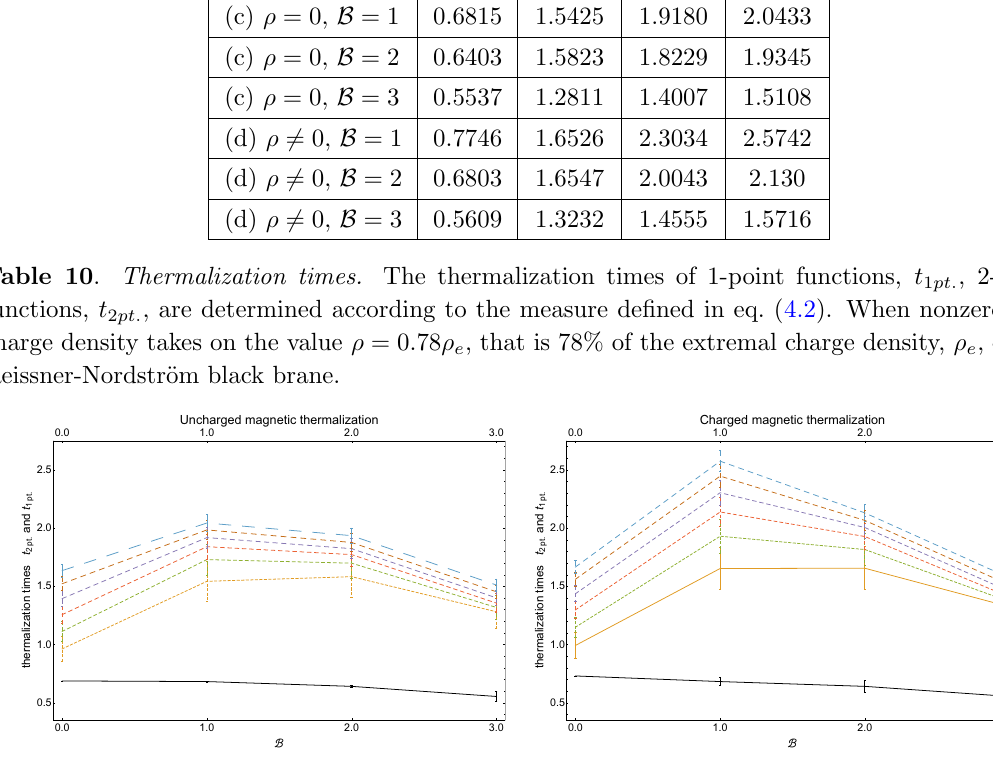
Figure 19 . Thermalization times as a function of the magnetic (cid:12)eld. Shown here are 2-point function thermalization times t 2 pt: (dashed lines) and the 1-point function thermalization times t 1 pt: (solid line) in a thermalizing (cid:13)uid. The dashed lines from bottom to top correspond to length separations l = 0 : 5 ; 0 : 7 ; 0 : 9 ; 1 : 1 ; 1 : 3 ; 1 : 5. Error bars indicate an estimate of our numerical error. Left: uncharged (cid:13)uid, (cid:26) = 0, B = 0 ; 1 ; 2 ; 3. Right: charged (cid:13)uid, (cid:26) = 0 : 78 (cid:26) e , B = 0 ; 1 ; 2 ; 3. Data points have been joined by straight lines to guide the